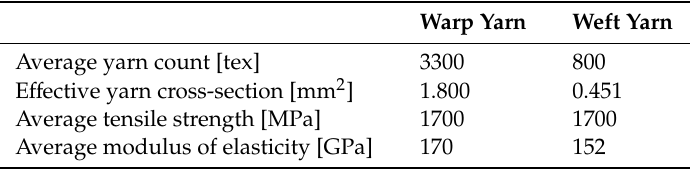
Figure 2. Geometry of the textile reinforcement under investigation. Table 3. Properties of carbon textile TUDALIT-BZT2-V.FRAAS [ 27 ].